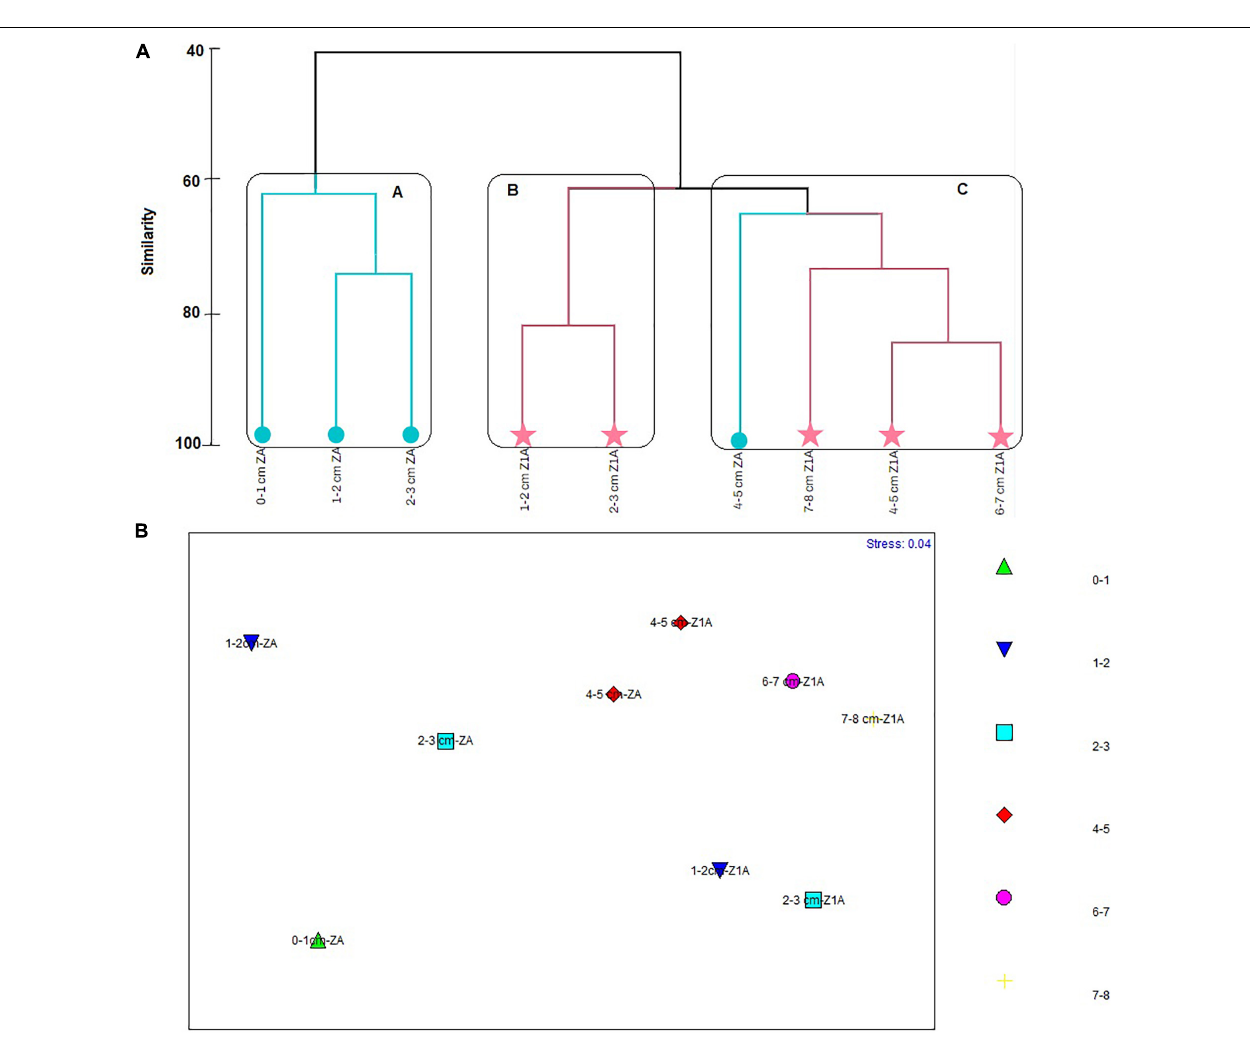
FIGURE 11 | (A) Similarity cluster. (B) Multidimensional Scaling Analysis (MDS) regarding the foraminifera species abundances registered in the strata of each sediment core (vertical